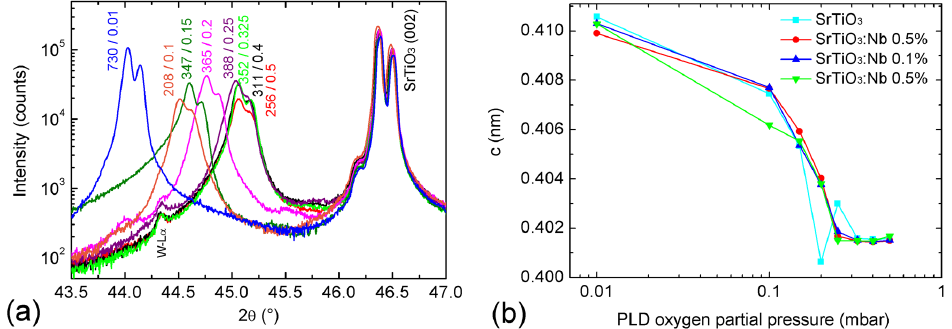
Figure 1. ( a ) X ‐ ray diffraction (XRD) 2 θ‐ω scans of BaTiO 3 ‐ BiFeO 3 composite thin films grown on SrTiO 3 :Nb(001) at the indicated oxygen partial pressures. The two numbers at the film peaks indicate the total composite film thickness in nm, and the oxygen partial pressure during pulsed laser deposition (PLD) growth, respectively. Note the K α 1/2 splitting of each peak. W ‐ L α is a spectral line from the X ‐ ray tube. The single ‐ phase contributions of BaTO 3 and BiFeO 3 cannot be resolved here; see Table 1. ( b ) PLD oxygen pressure evolution of the c ‐ axis lattice parameters calculated from 004 peaks of four BaTiO 3 ‐ BiFeO 3 composite thin films grown simultaneously for each growth pressure at the indicated substrates. See Table 1 for the values of the c ‐ lattice parameters and more structural details.